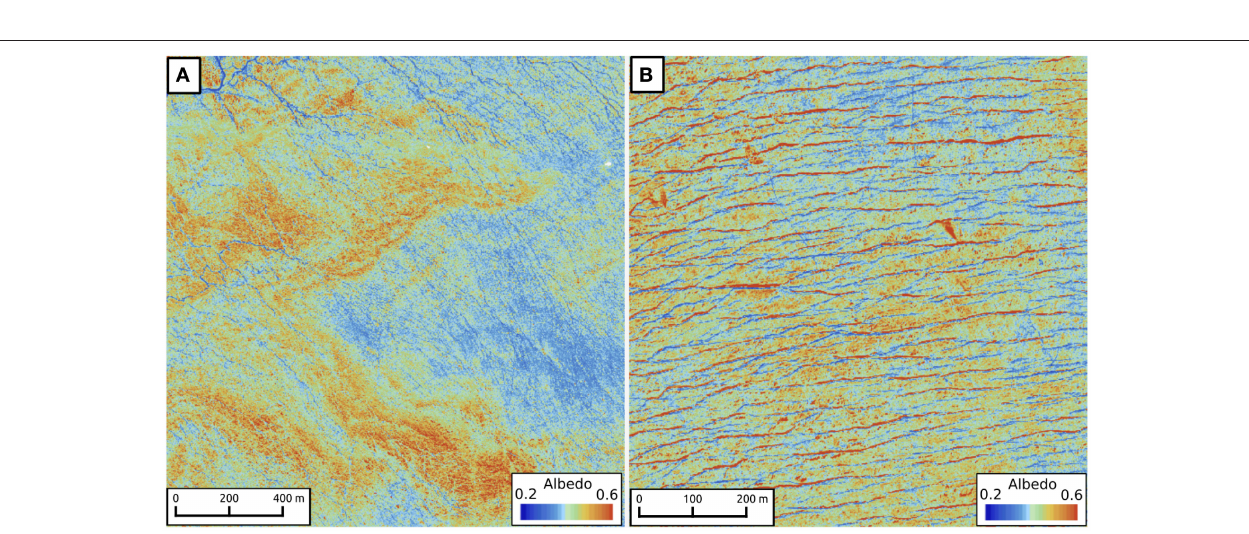
FIGURE 9 | (A) Relatively clean bare ice with cryoconite holes potted on the surface. (B) Crevassed area of Isunguata Sermia.